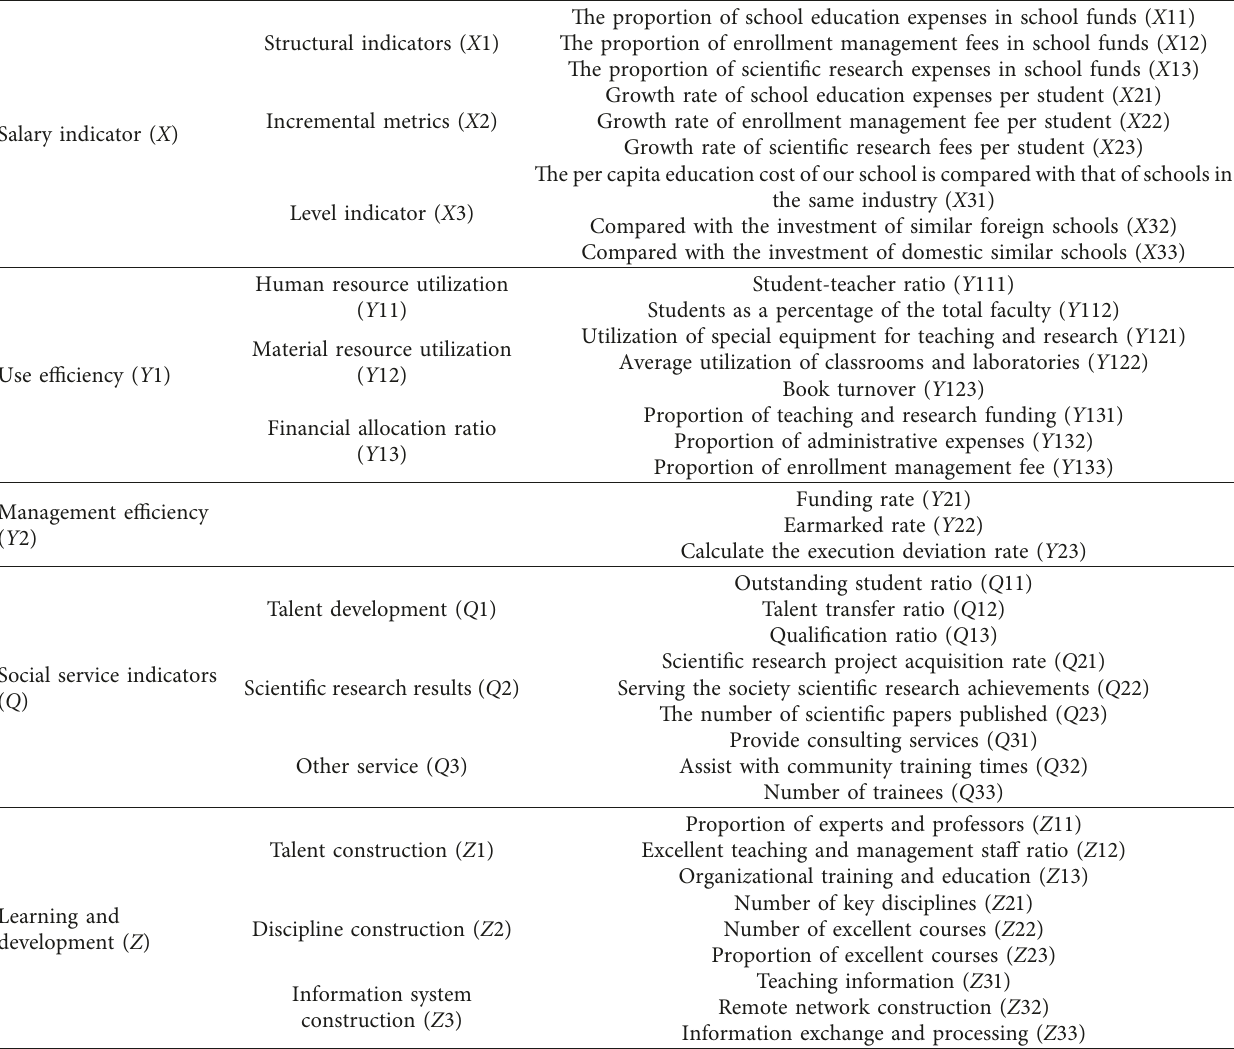
Table 3: Evaluation indicators.